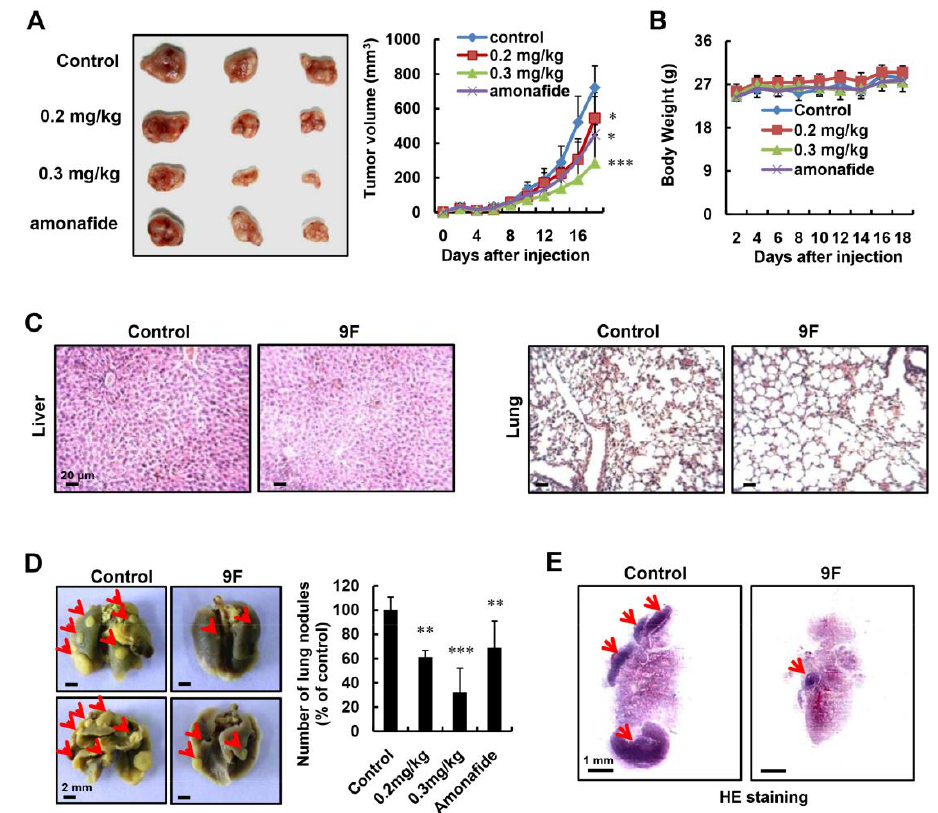
Figure 7. Treatment with 9F inhibited tumor growth and metastasis of CRC in vivo. ( A ) Tumor volumes of mice treated by 9F and amonafide were evaluated on the indicated days. Amonafide was used as positive control. * p < 0.05, *** p < 0.001. ( B ) Body weights of mice were measured. ( C ) H&E staining of liver and lung from mice bearing CRC cells after treatment with or without 9F (0.3 mg / kg). ( D ) The representative images of lung metastasis nodules from mice bearing CRC cells after treatment with or without 9F (0.3 mg / kg). The number of metastasis nodules was recorded. Amonafide was used as positive control. ** p < 0.01, and *** p < 0.001. ( E ) The representative images of H&E staining of lung metastasis from mice treated with or without 9F (0.3 mg / kg).